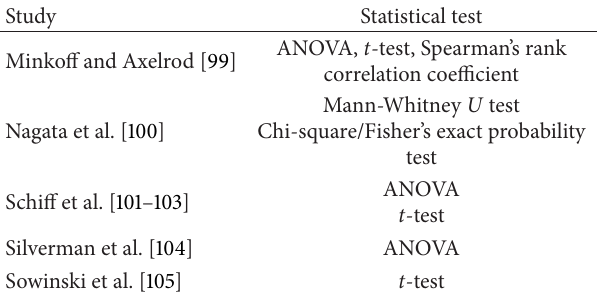
Table 6: Statistical tests used in the included